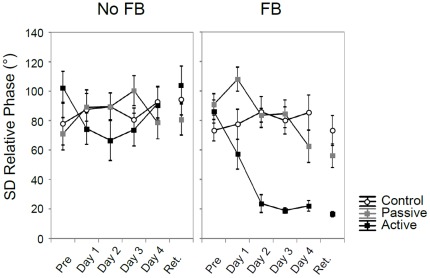
Performance of standard deviation of relative phase across days.Standard deviation (SD) of relative phase in degrees (°) across practice for each group in the absence (left) and presence of augmented feedback in the form of a Lissajous plot (right). Error bars represent SE of mean.